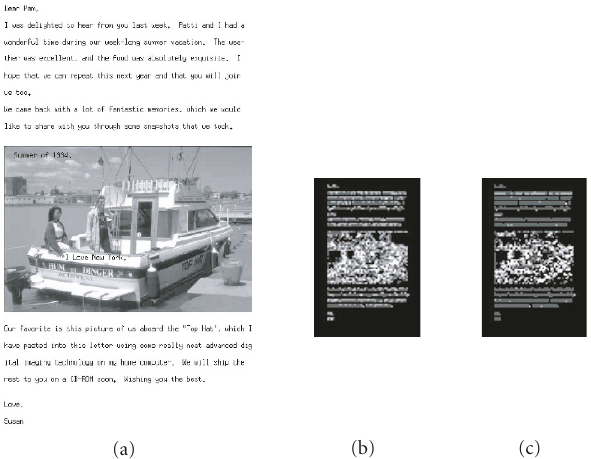
Figure 11: Results for “Compound” image: (a) original image; (b) matrix CLASS obtained by Algorithm 2; (c) matrix CLASS obtained by Algorithm